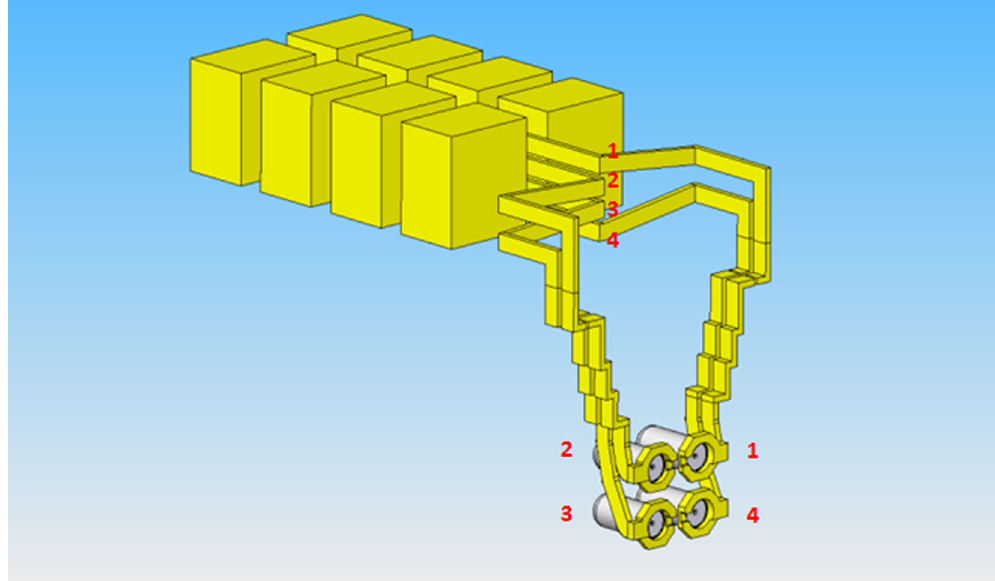
FIG. 11. Strip line connections from PSU to magnetic horns.